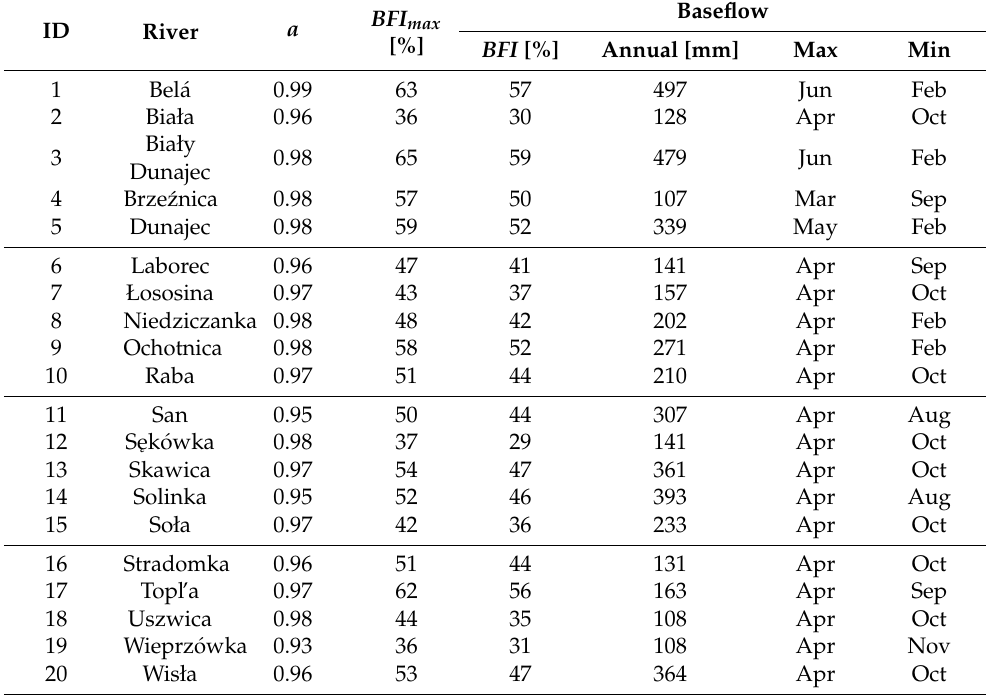
Table 2. Parameters used for Eckhardt’s digital baseflow filter ( a and BFI max ) and baseflow character- istics for the studied